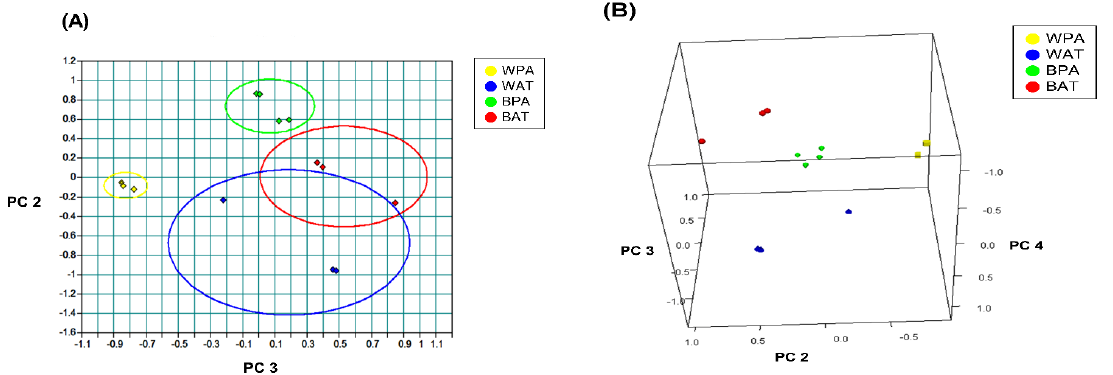
Figure 6. Discrimination of adipocytes by principal component analysis. ( A ) Two-dimensional drawing of identification by PCA, ( B ) three-dimensional drawing of identification by PCA.